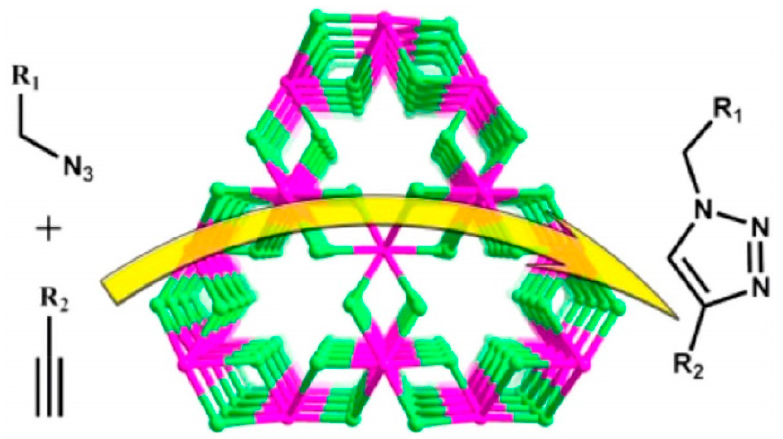
Figure 11. Schematic representation of the simplified 3D network of Cu-MOF. Reproduced from [104] with permission from the American Chemical Society, copyright year: 2015. Table 5. Copper-based MOFs for the synthesis of 1,2,3-triazole via CuAAC reaction.